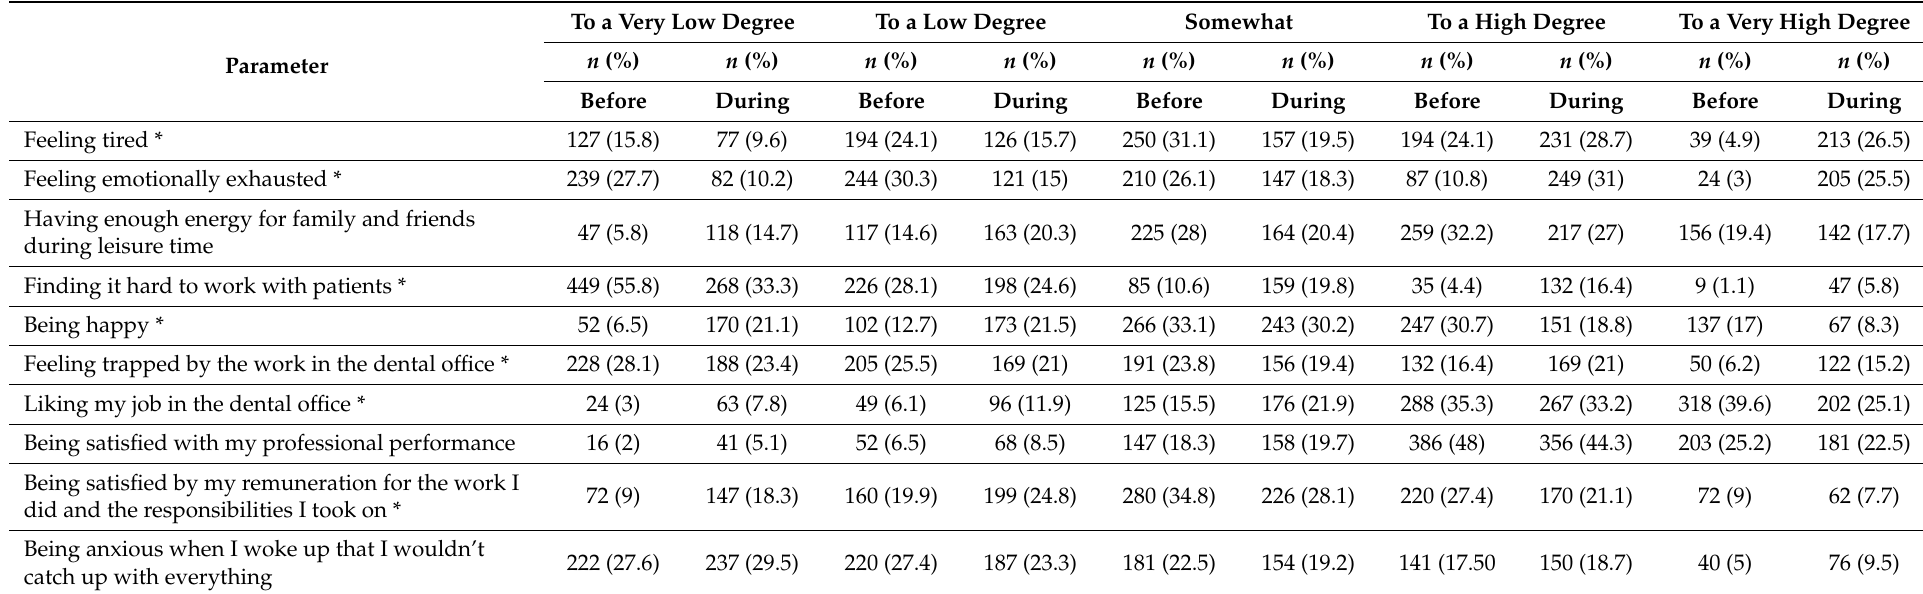
Table 1. Selected findings in burnout estimation before and during the